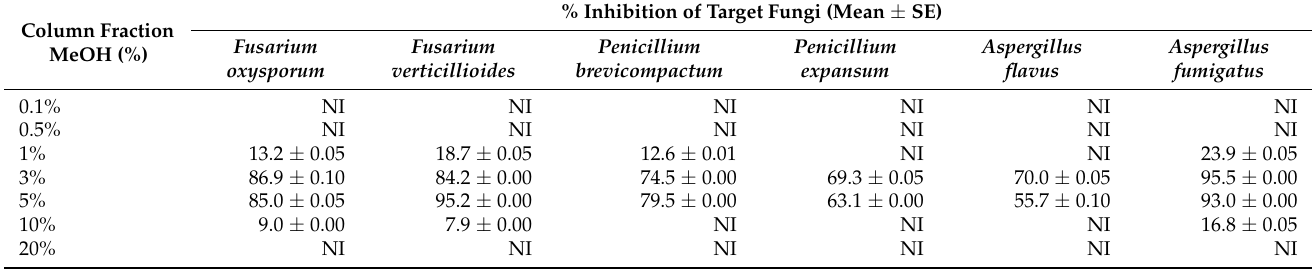
Figure 2. MS analysis of majority peak in 5% fraction 50.172 min, m/z 266 and 50.98 min, m/z 338 (trimethylsililated) corresponding to methylated form of dihydrogen-deoxy-kramerixin. Table 4. Inhibition effect of K. lapachea extract fractions on pathogenic and toxinogenic fungi at concentration 0.5 mg mL − 1